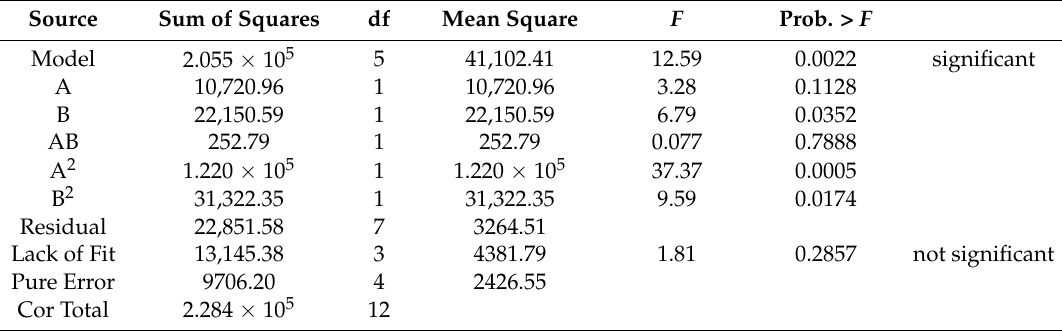
Table 5. Analyses of variance (ANOVA) for response surface model for toughness of POM composites using